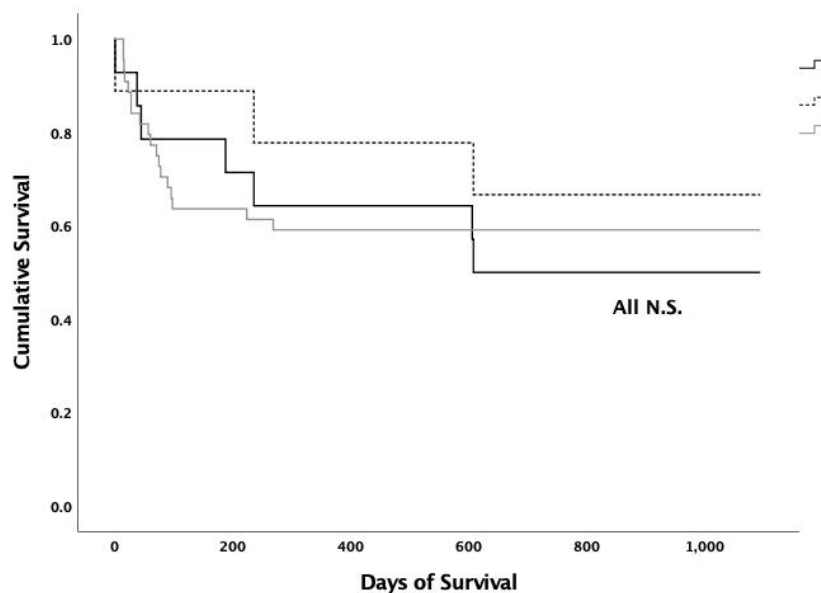
Figure 1. Kaplan–Meier Analysis: Between groups no statistically significant di ff erences for three-year survival could be shown. All liver resection patients vs. late re-transplantation patients three-year survival: 50.0% vs. 59.1% ( p = 0.733). Liver resection in patients who were potentially retransplantable vs. late re-transplantation patients three-year survival was 66.7% vs. 59.1% ( p = 0.598).